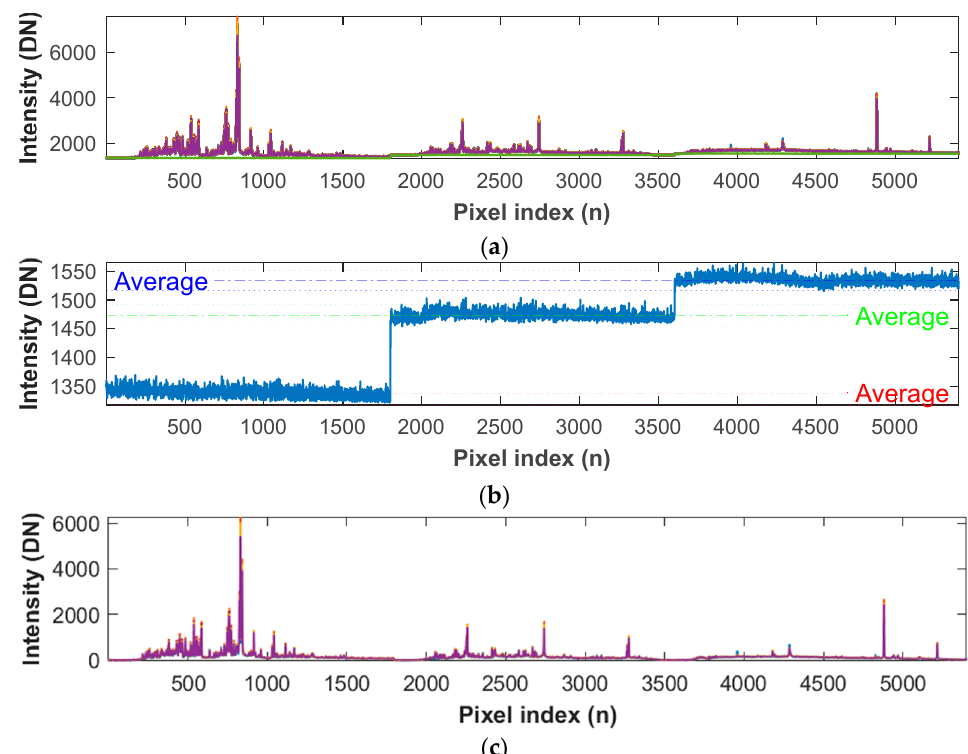
Figure 2. Removing the background from 58 LIBS spectra for Sample-A06: ( a ) raw spectra; ( b ) noise and background; ( c ) spectral signals.